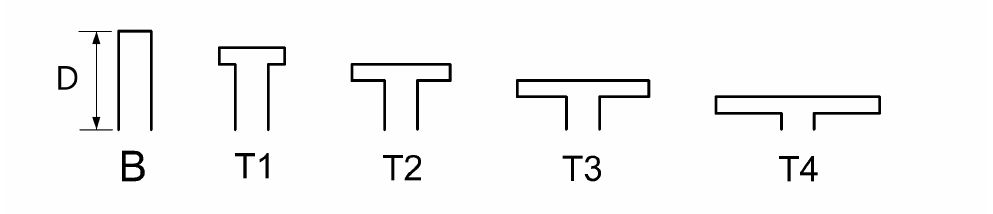
Figure 2. T-shape groove geometry compared to the baseline.